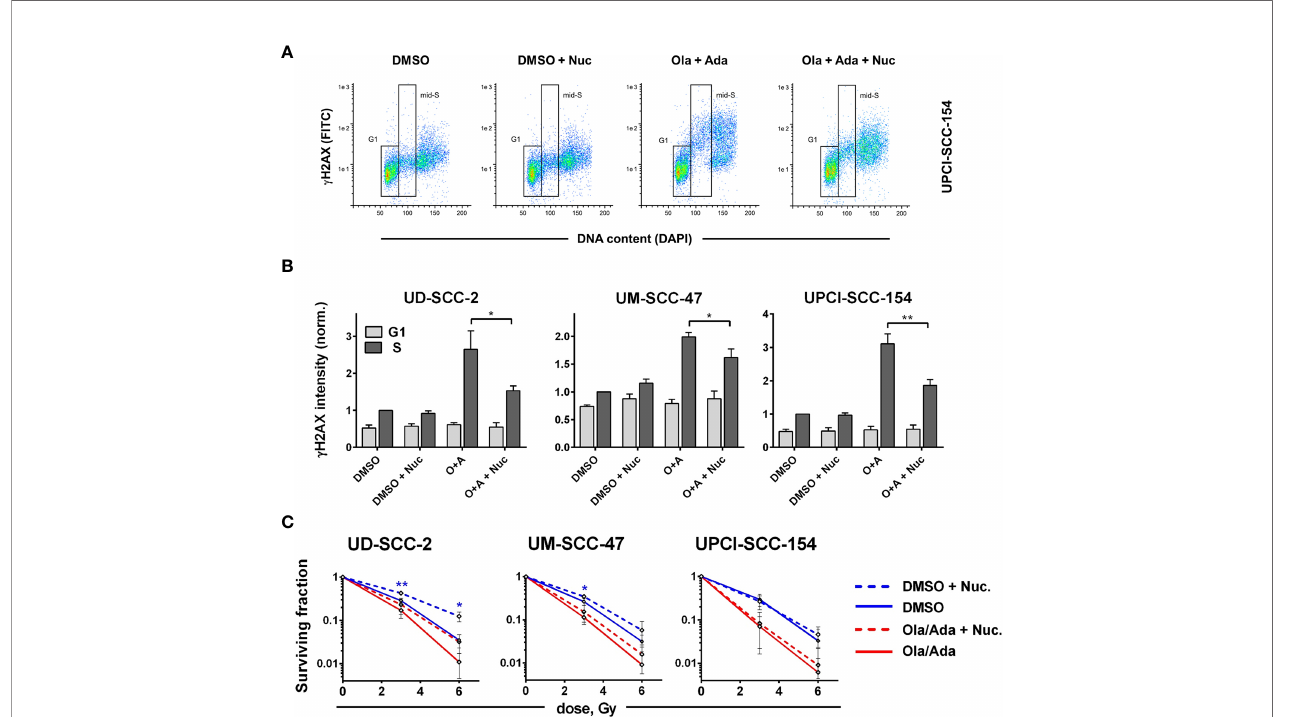
FIGURE 6 | Cell line-dependent induction of radioresistance through nucleoside supplementation. Exponentially growing cells were treated with or without the combination of olaparib and adavosertib and with or without external nucleosides as indicated. (A) Example of gating for g H2AX intensity measurement in G1 and mid-S phase cells as assessed by DAPI co-staining. The cells were fi xed after 4 h of treatment and analyzed for g H2AX induction by fl ow cytometry. (B) Bars depict the average median g H2AX staining intensity of cells in G1 and mid-S phase. Values were normalized to the intensity of DMSO-treated mid-S phase cells of the respective experiments. Asterisks mark statistically signi fi cant differences upon nucleoside supplementation. (C) Two hours after addition of inhibitors ± nucleosides the cells were irradiated and after further 24 h seeded for colony formation without addition of inhibitors. Asterisks mark statistically signi fi cant differences in survival upon nucleoside supplementation, color indicates solvent controls or inhibitor treatment. Differences between DMSO treatment and dual inhibition without nucleoside supplementation (solid lines) were signi fi cant for all cell lines (not indicated). Signi fi cant changes are indicated with * and **indicating p ≤ 0.05 and p ≤ 0.01, respectively (two-tailed Student ’ s